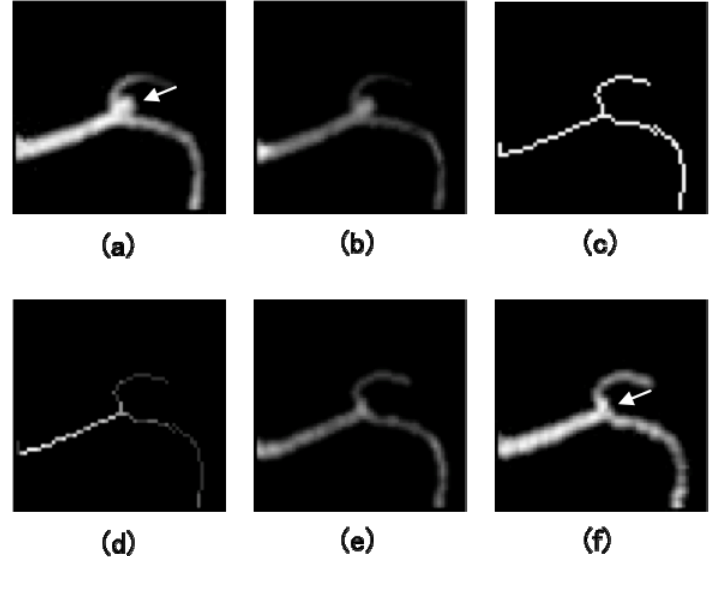
Figure 11. Illustrations of images produced in each step of the shape-based difference image technique: (a) segmented vessel, (b) distance transformation, (c) determination of vessel skeleton, (d) logical AND between skeleton image and distance transformed image, (e) smoothing skeleton image with distance value by rind filter, and (f) vessel with suppressed local change on thickness